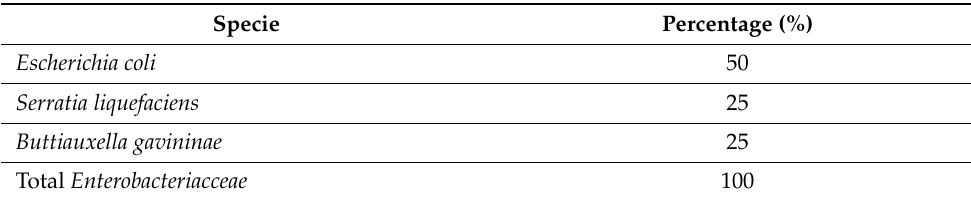
Table 3. Percentage of Enterobacteriacceae isolates identified in fresh goat meat free of antibiotic